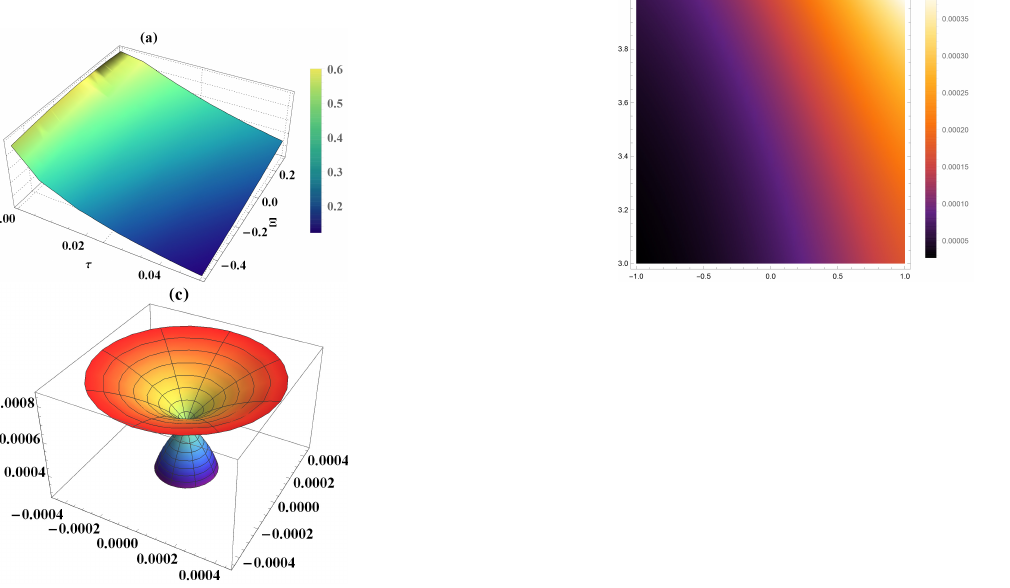
Figure 3. Solitary wave solution of Equation (32) in ( a ) three–dimension, ( b ) density and ( c ) spherical plot three–dimensional for a = 3, (cid:36) =